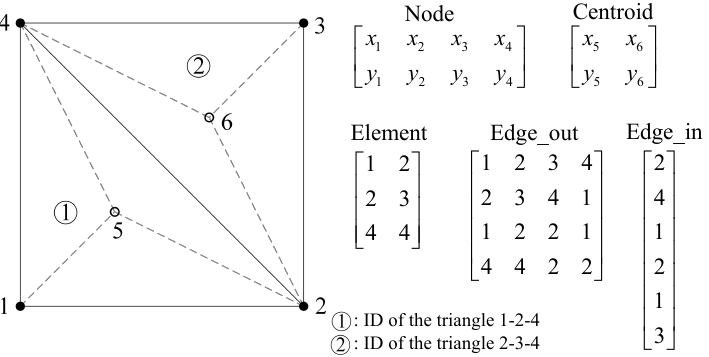
Figure 5. Illustration of the matrices “Node”, “Centroid”, “Element”, “Edge_out” and “Edge_in”, using two adjacent triangles as